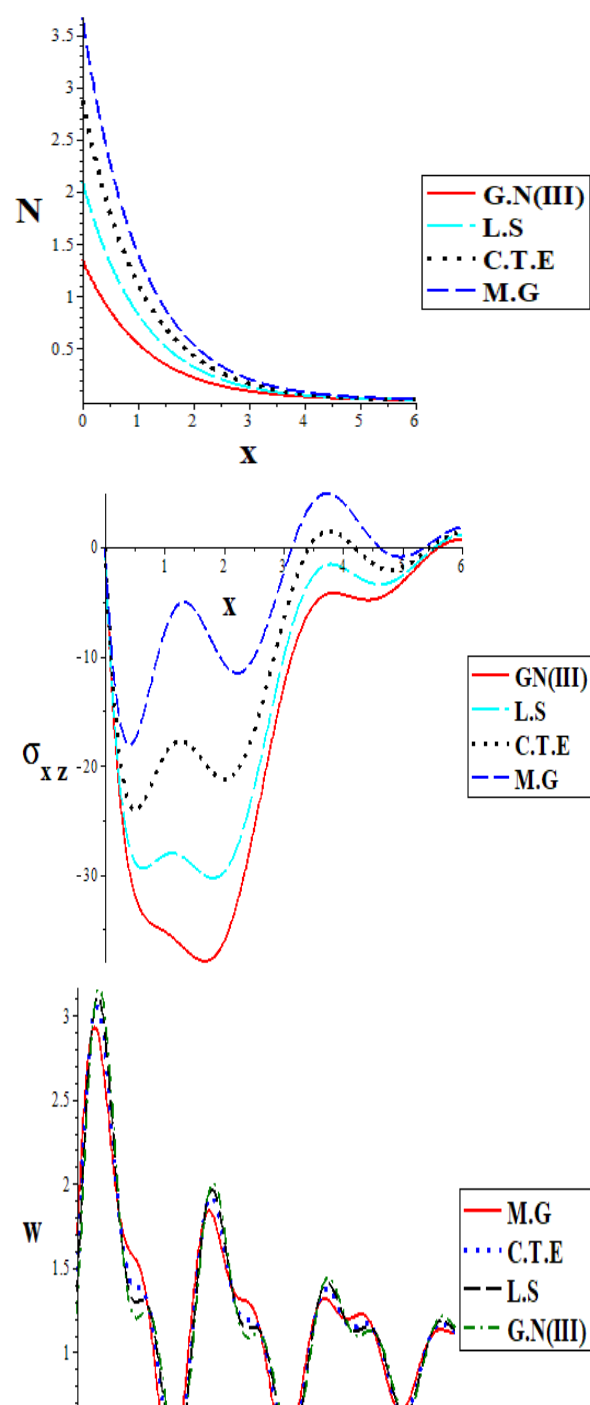
14 of 22 Figure 1. The main changes in the physical fields plotted against the horizontal distance for various short times in a rotational field and under initial hydrostatic stress The numerical results in Figure 2 illustrate how the new MGT theory’s predictions (including the MGT equation) differ from those of other photothermoelastic models under the impact of the rotational field and initial stress. Whereas the classical thermoelastic (CTE) model is obtained when